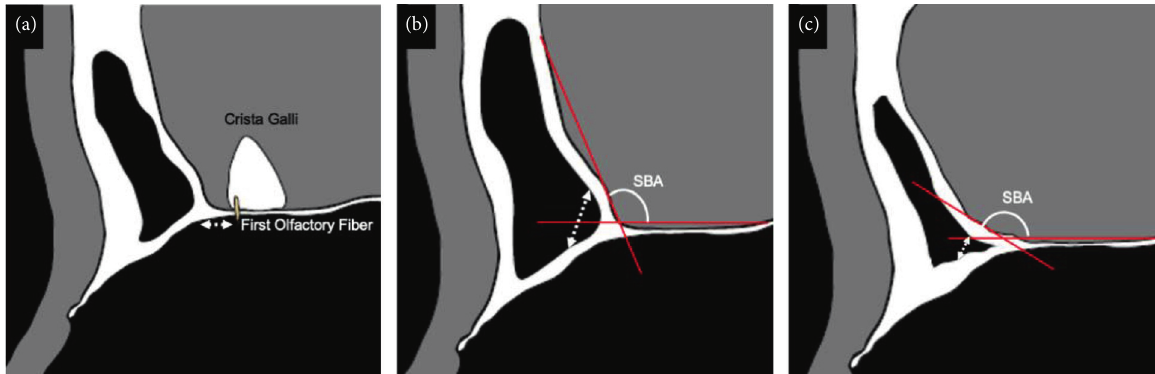
Figure 4: Relationship between the floor of the frontal sinus, the posterior wall of the frontal sinus, and the first olfactory fibre in sagittal computed tomography. (a) Relationship between the first olfactory fibre and the posterior wall of the frontal sinus. (b, c) Relationship between the skull base-frontal sinus angle (SBA) and the posterior wall of the frontal